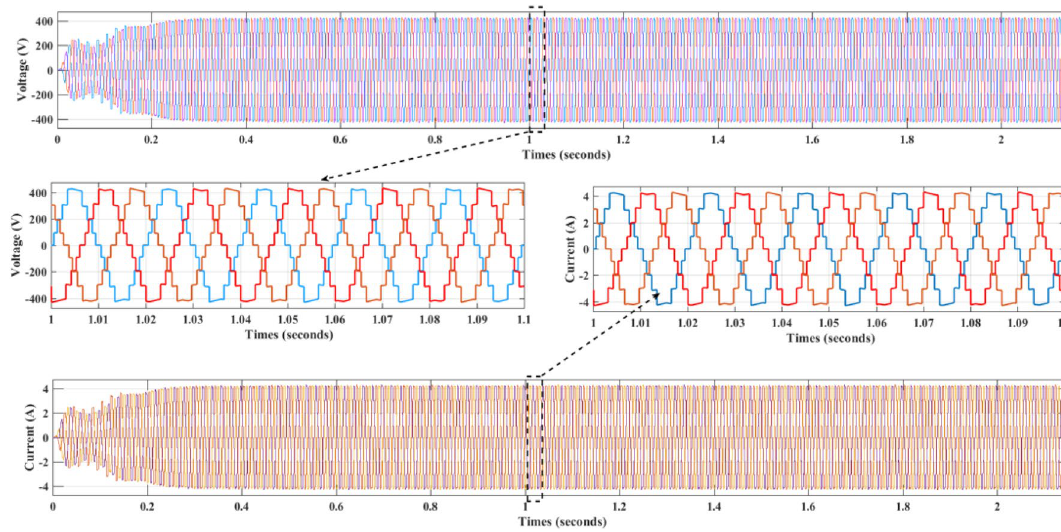
Fig.6 Simulation circuit of seven-level modified cascaded half-bridge MLI with PC